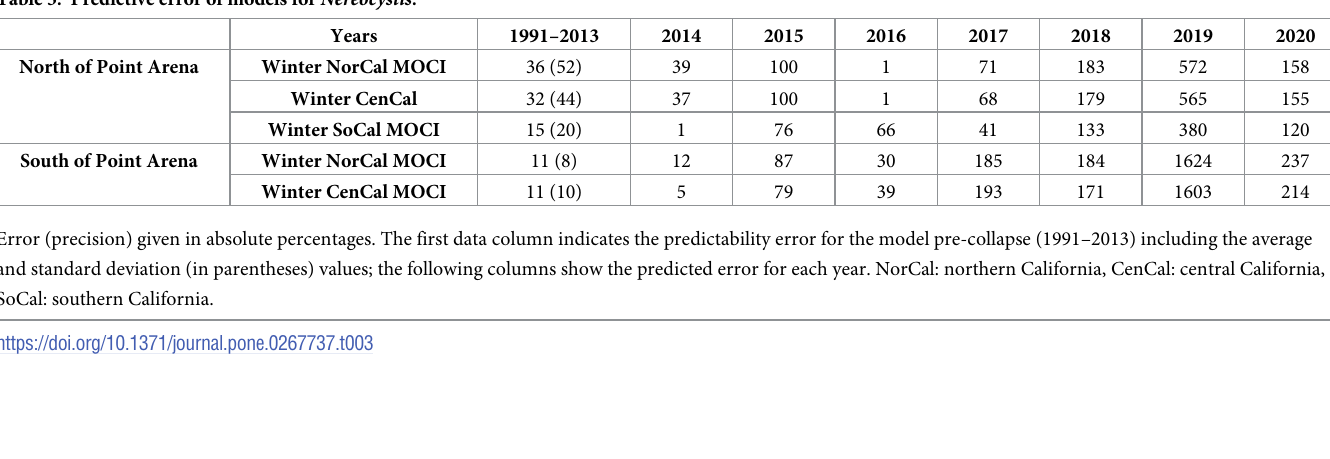
Table 3. Predictive error of models for Nereocystis .